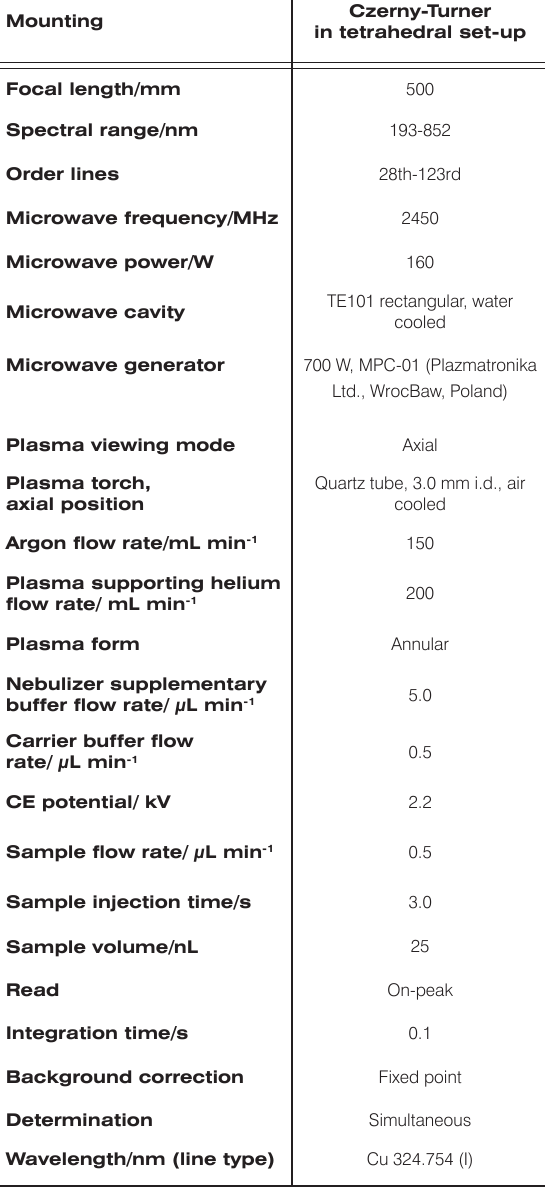
Table 1. Instrumental parameters for the μCE-MIP-OES system.